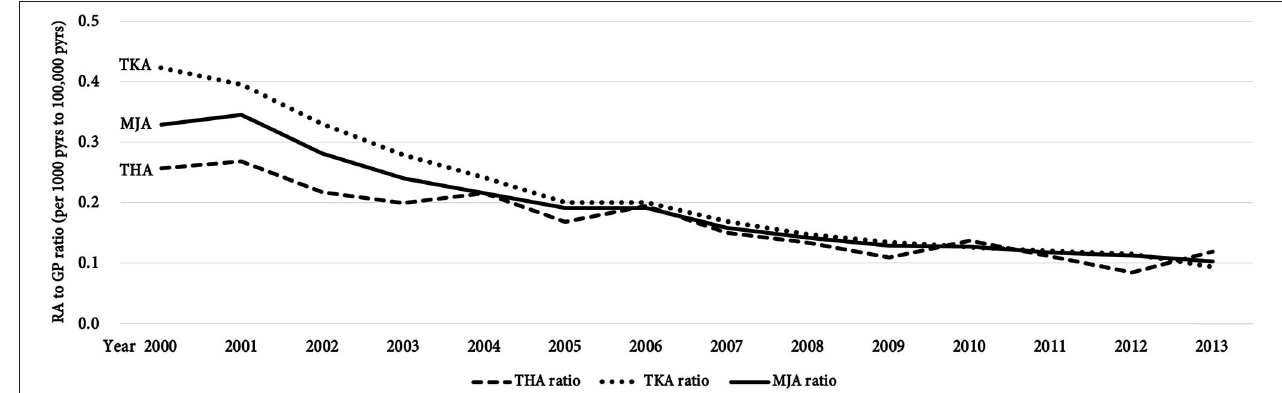
FIGURE 3 | Incidence ratio of rheumatoid arthritis (RA) patients to general hospitalization patients (GP) from 2000 to 2013 [per 100,000 person years (pyrs) in GP and per 1,000 pyrs in RA patients], indicating the proportion of RA patients receiving total hip arthroplasty (THA), total knee arthroplasty (TKA), and major joint arthroplasty (MJA) among GP cohort.